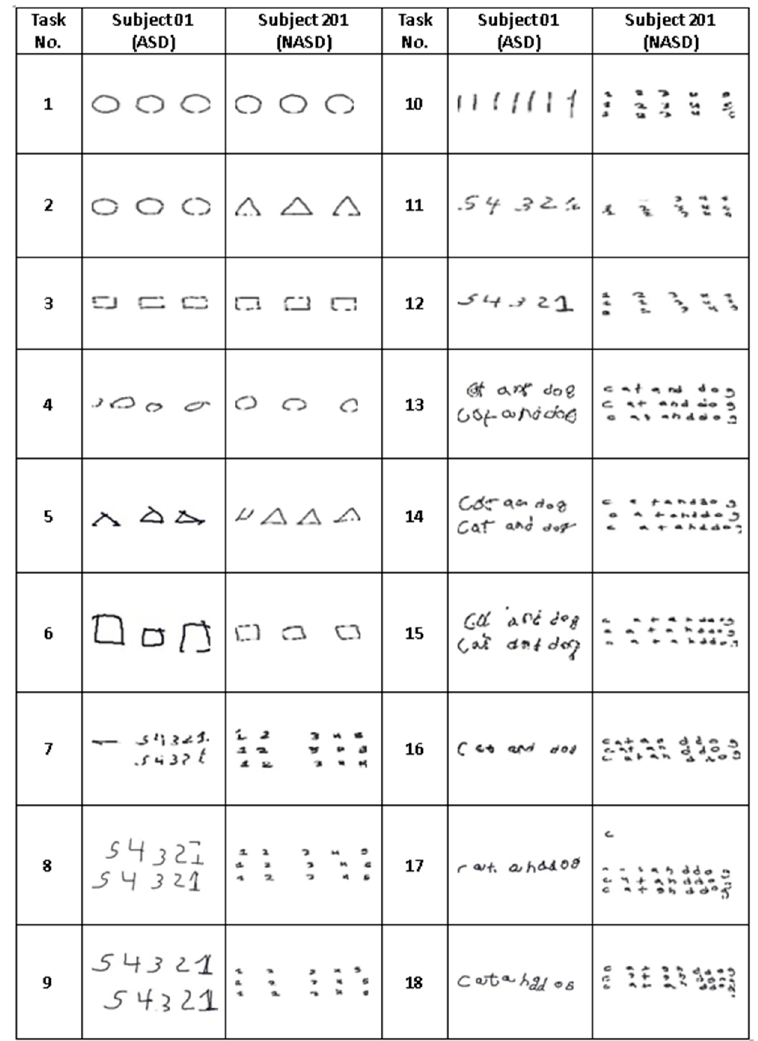
Figure 3. Example of all tasks for ASD and non-ASD subjects.